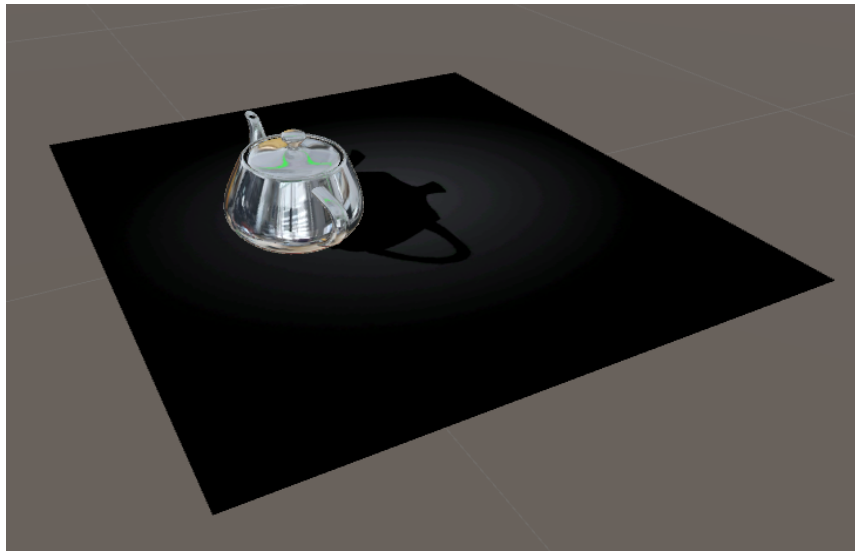
Figure 15. Negative shadow